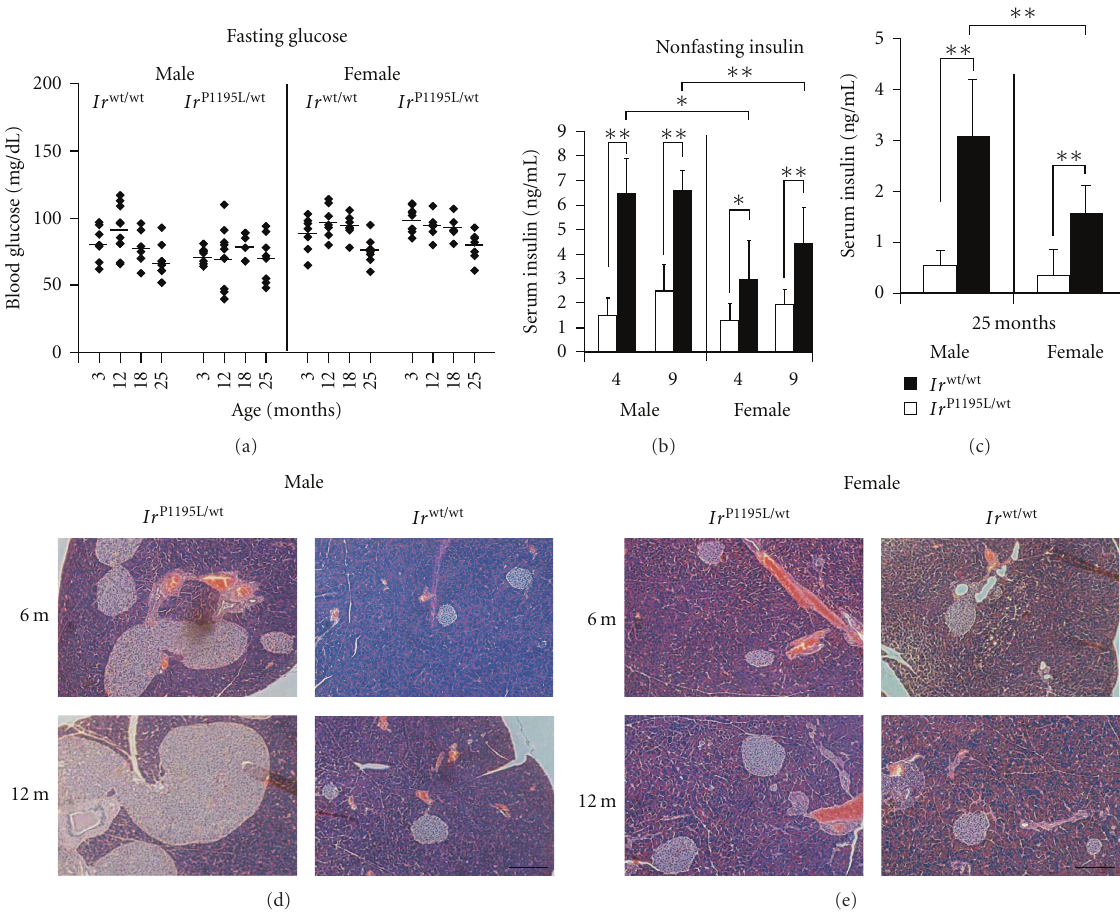
Figure 2: The blood glucose and serum insulin concentrations in Ir P1195L / wt mice. (a) The blood glucose concentrations of fasting mutant male and female mice were assessed. All Ir P1195L / wt mice exhibited blood glucose concentrations within the same range as the Ir wt / wt mice ( n = 6–10 for each genotype). (b) The serum insulin concentrations were determined in the nonfasting state of 4- and 9-month-old Ir wt / wt and Ir P1195L / wt mice ( n = 7 for each genotype). (c) The serum insulin concentrations were determined in the fasting state of 25-month-old Ir wt / wt and Ir P1195L / wt mice ( n = 5 for each genotype). The insulin concentrations were significantly increased in both female and male Ir P1195L / wt mice compared with the Ir wt / wt mice. (d, e) The histochemical analyses of the pancreas of Ir P1195L / wt mice. (d) The Ir P1195L / wt male mice exhibited extensive enlargement of the Langerhans islets compared to Ir wt / wt mice. (e) In addition, the size of islets in Ir P1195L / wt female mice was larger than in Ir wt / wt female mice. The scale bars indicate 200 μ m. ∗ P < 0 . 05, ∗∗ P < 0 . 005 by Student’s t -